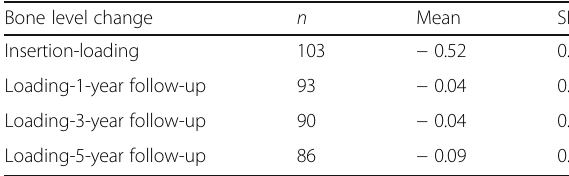
Table 3 Mean crestal bone level changes in